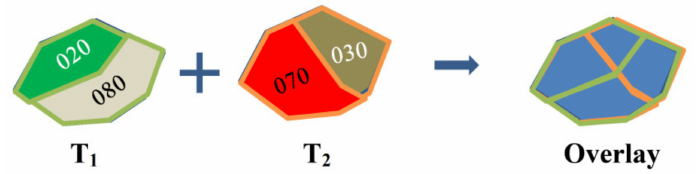
Figure 2. Overlay analysis of the changed patch of two